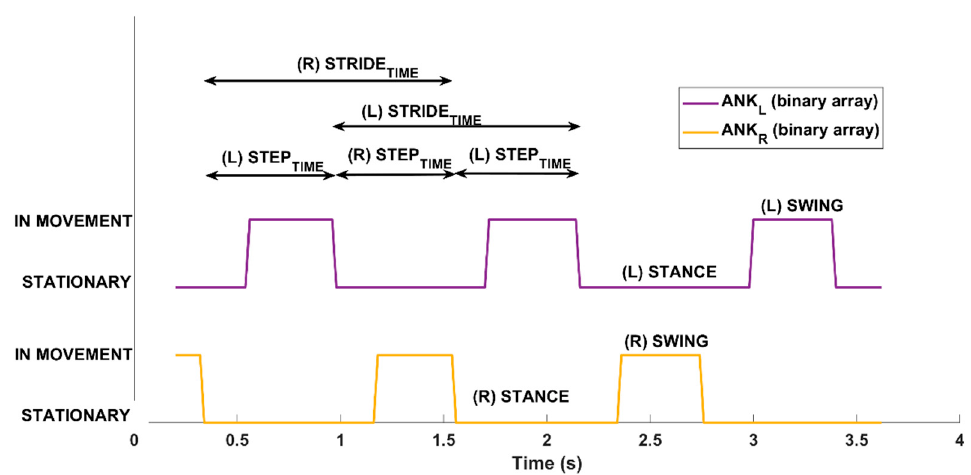
Figure 5. Step segmentation algorithm: Automatized analysis from the binary arrays within the time window used for the analysis to estimate gait parameters for left and right legs. The “stationary” and “in movement” periods for the two legs are displayed. In addition, the figure shows some of the steps for left (L) and right (R) legs from which both spatial and temporal information are evalu- ated.